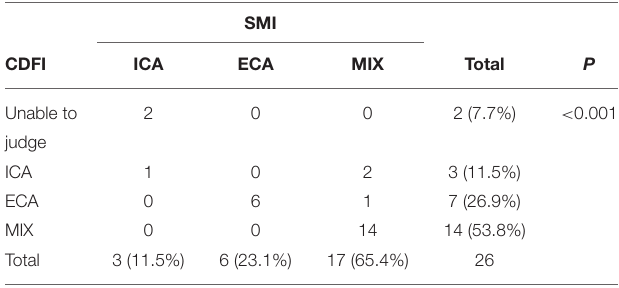
TABLE 3 | Characteristics of feeding arteries and their differences between SMI and CDFI.